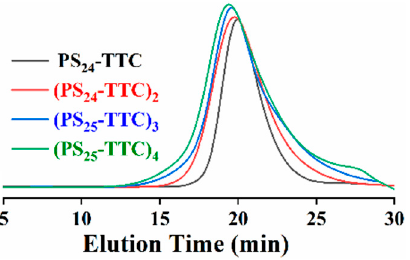
Figure 2. GPC traces of PS-TTC)n (n = 1, 2, 3, 4) with similar PS arms chain at about 25.